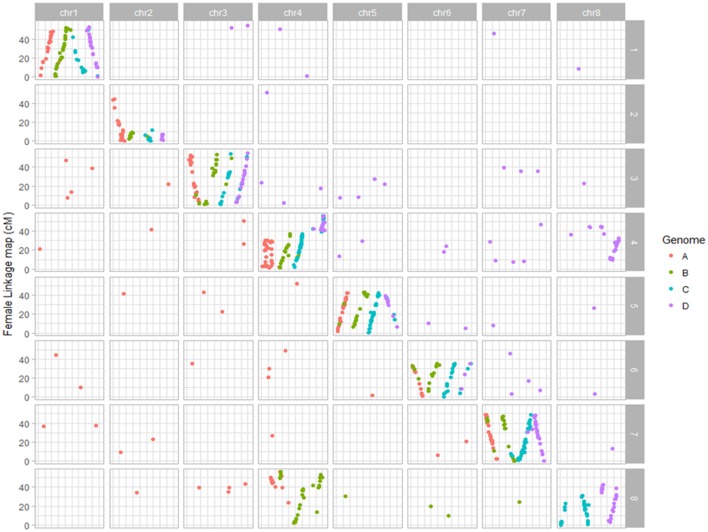
Dot plot displaying the grouping pattern and positions of SNPs on 32 linkage groups of alfalfa 3010 linkage map. Of the 32 groups, each four homologs groups were assigned to a chromosome based on synteny with Medicago truncatula genome.